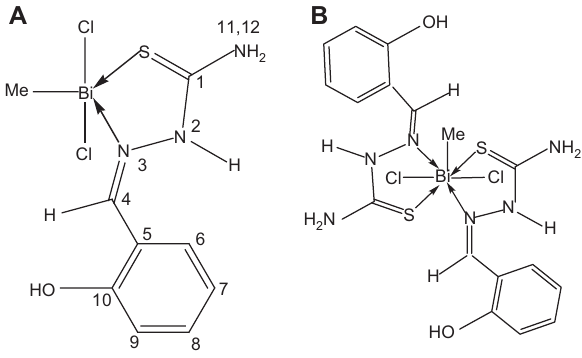
Figure 1 Proposed structure of: (A) (3) and (B) (4)